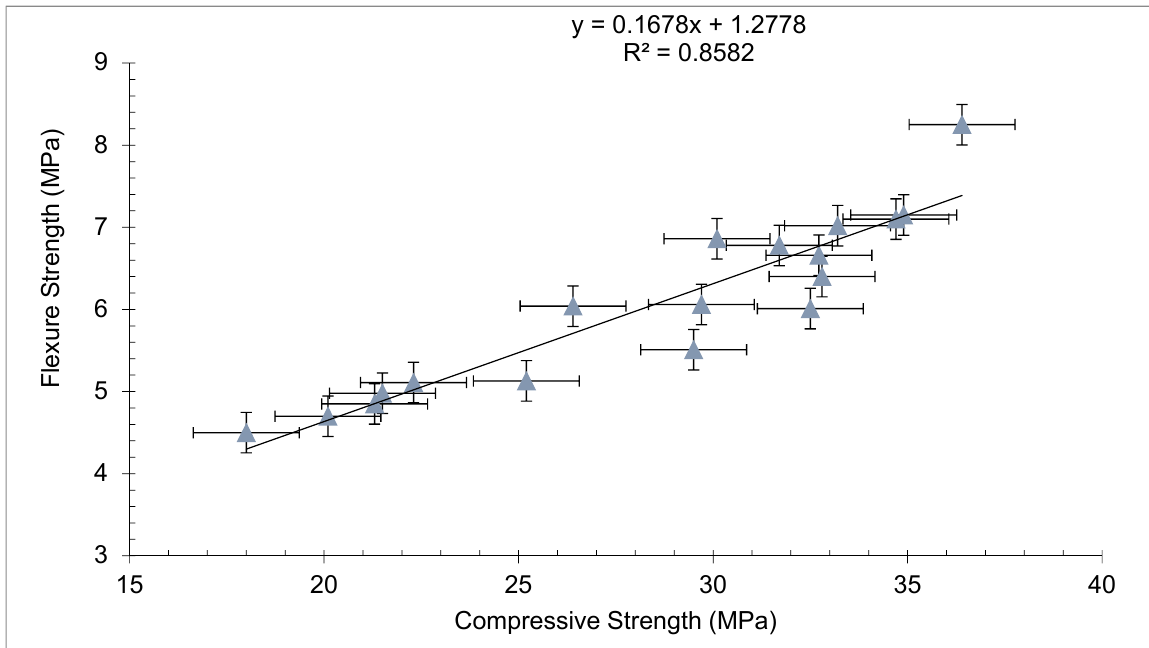
Figure 12. Correlation between compressive strength and flexure strength.